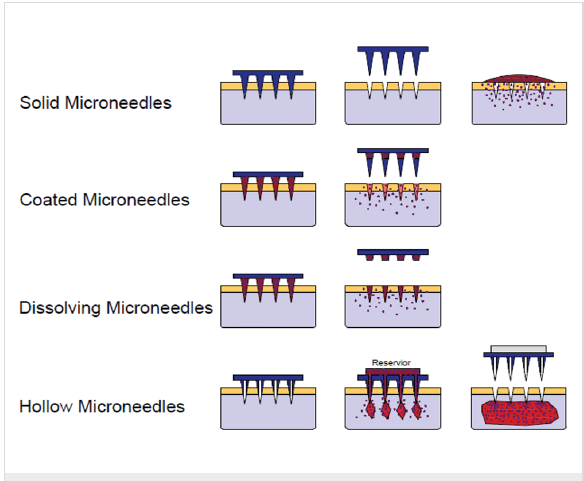
Figure 1: Schematic illustration of methods of microneedle application to the skin for drug delivery purposes.